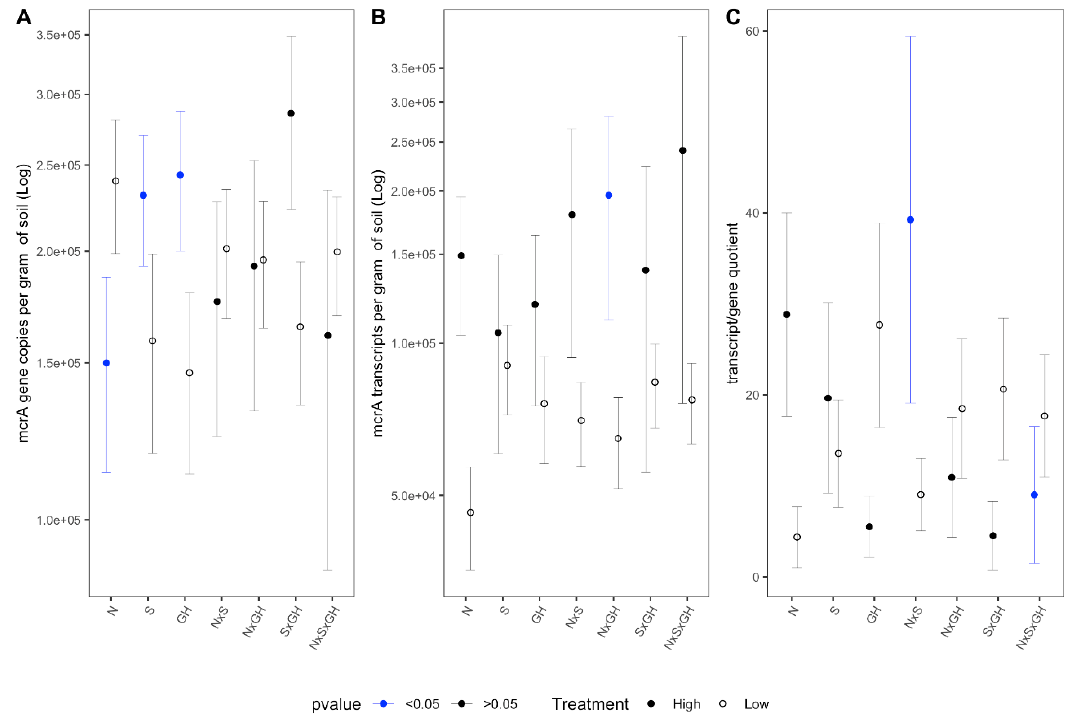
Figure 1. Overall results per treatment effect for (A) abundance of mcr A gene copies, (B) abundance of mcr A transcripts, and (C) transcript/gene quotient (note the logarithmic scales on vertical axes). Error bars represent one standard error. The significance estimates are based on the MLR model ( log β S + β GH + β (N×S) + β (N×GH) + β (S×GH) + β (N×S×GH) + ε ). ‘Low’ refers to the low (ambient) 2 3 4 5 6 7 treatment level and ‘High’ to treatments involving N (30 kg ha -1 yr -1 ) or S (20 kg ha -1 yr -1 ) amendment or warming (GH), singly and in combination. Number of replicates: for main effects, n = 40; for two-way interaction effects, n = 20; and for three-way interaction effects, n = 10. For further details see Table A1